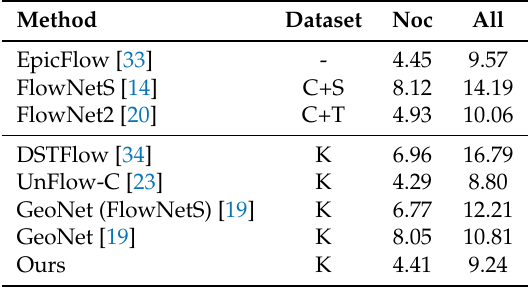
Figure 6. Comparison of optical flow estimation between Yin et al. [19] and ours on KITTI Flow 2015 dataset. The ground truth is interpolated for visualization purpose. Our method performs better in both occluded and overall regions. Table 6. The reported Average end-point error (AEE) on KITTI flow 2015 over all pixels (All) and over non-occluded pixels only (Noc). C denotes dataset FlyingChairs, S denotes Sintel and T is